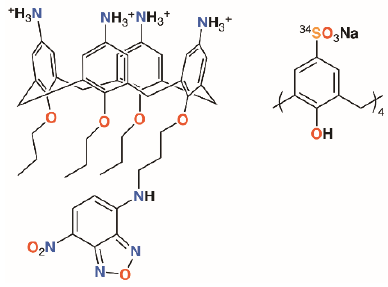
Figure 2. Matthews’ fluorescent calixarene ( left ) and Coleman’s calixarene radiotracer ( right ).